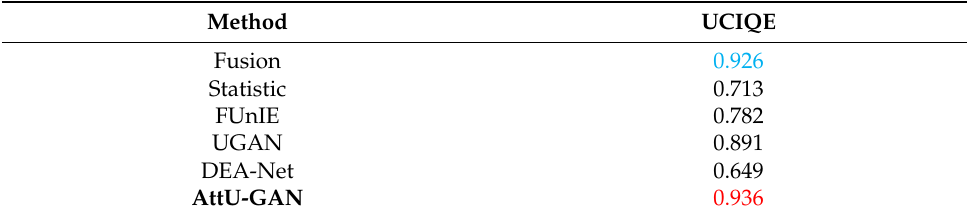
Table 2. No-reference image quality evaluation (UCIQE).